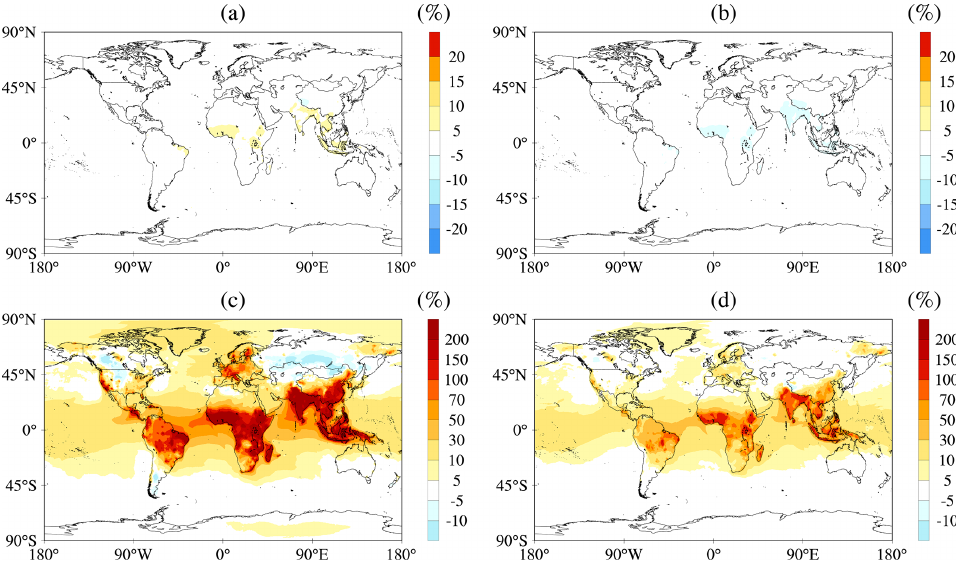
Figure 11. Relative change of number concentrations of CN10 in the (a) LV_POA experiment, (b) HV_POA experiment, (c) PPD0.5 experiment, and (d) OCD0.5 experiment to that in the base